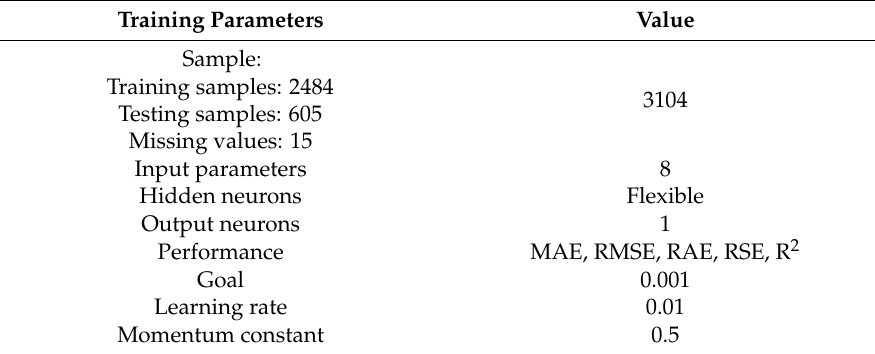
Table 4. Training parameters for the multilayer perceptron (MLP)